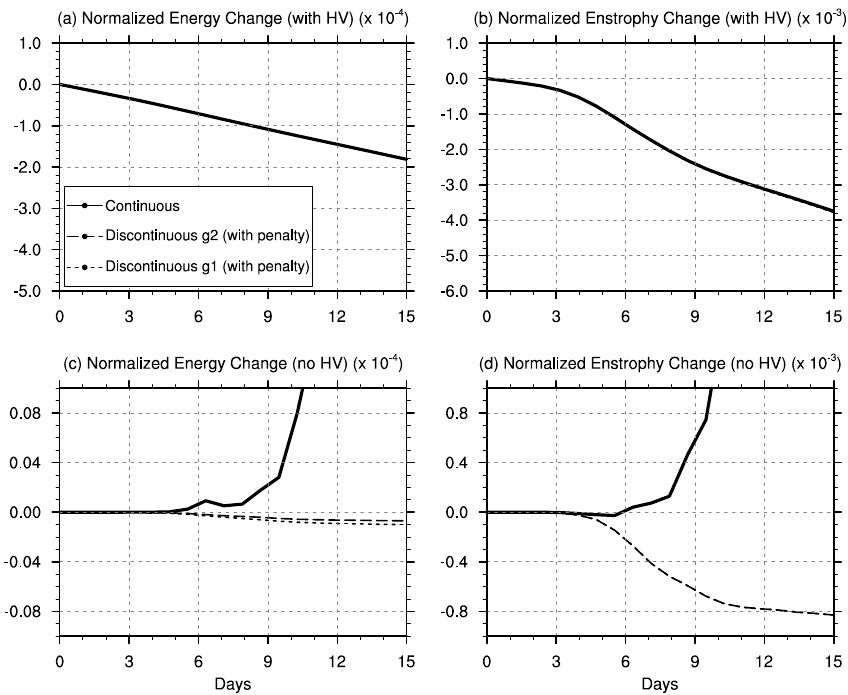
Figure 9. Normalized total energy and potential enstrophy change for the Rossby–Haurwitz wave test with n e = 16 and n p = 4 over a 15-day simulation. In (a) and (b) all simulations show roughly equivalent energy and enstrophy loss and so all lines are coincident. In (c) and (d) the Fig. 9. Normalized total energy and potential enstrophy change for the Rossby-Haurwitz wave test with simulation with continuous elements is beginning to experience instability, leading to total energy and enstrophy growth after approximately 6 days of simulation